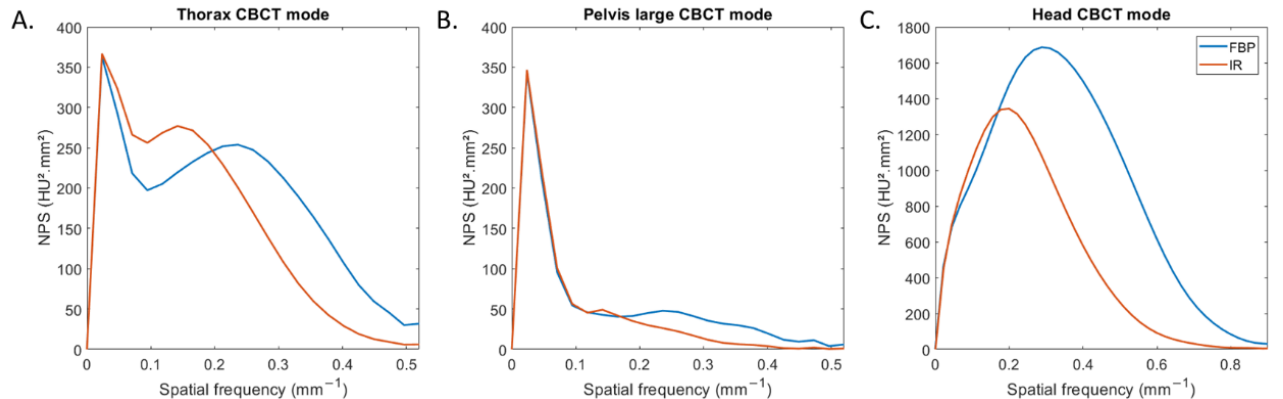
Figure 2. Noise power spectrum (NPS) curves obtained with filtered-back projection and iterative reconstruction for the three CBCT acquisition